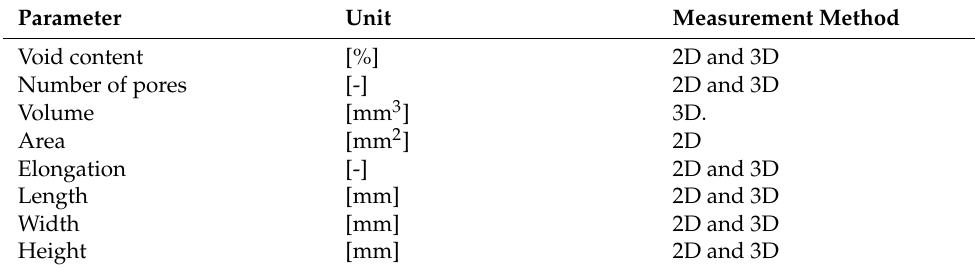
Table 5. Two-dimensional and three-dimensional comparison parameters.